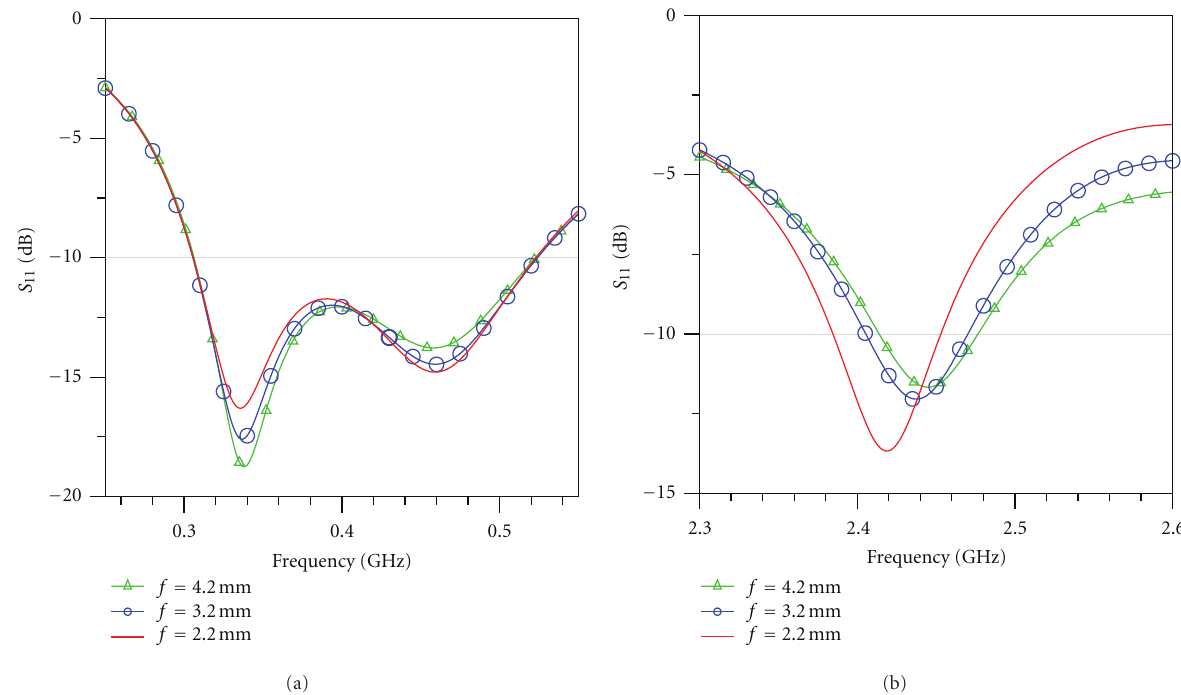
Figure 4: Simulated return loss for parameter of f in pork skin (a) at ISM (433MHz) band, (b) at ISM (2.4 GHz) band.